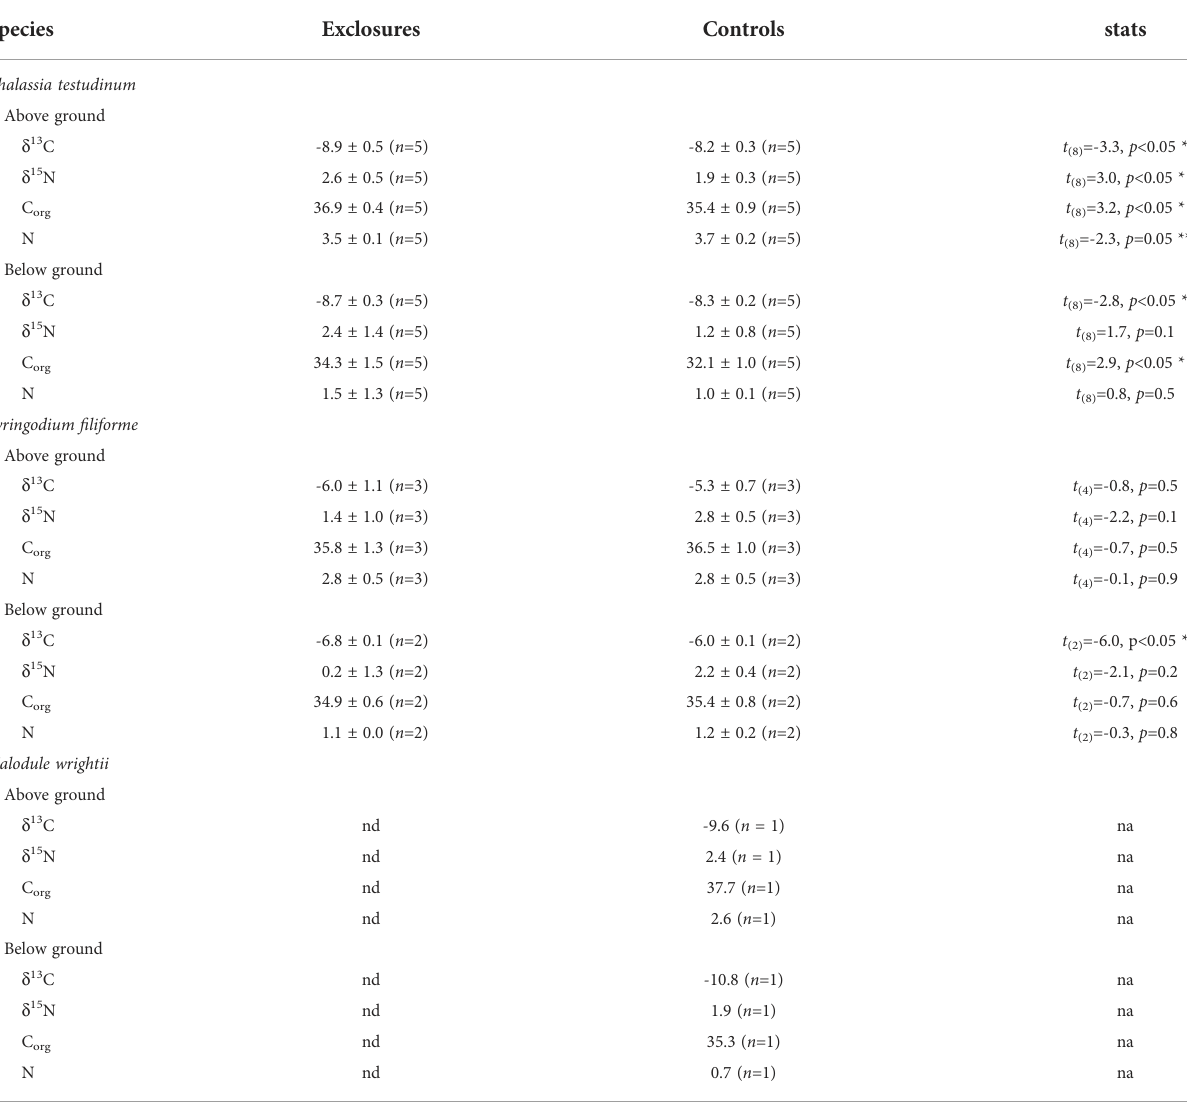
TABLE 2 Stable isotope ( ‰ ) and elemental composition (%) of seagrass biomass per species within exclosures and control plots following 13 months of megaherbivore exclusion at Cahuita National Park, Costa Rica. Species Exclosures